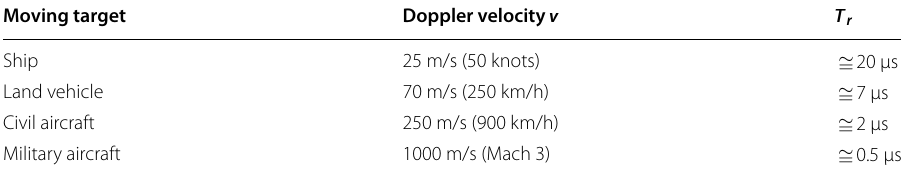
Table 1 T r for different moving targets (X-band) Moving